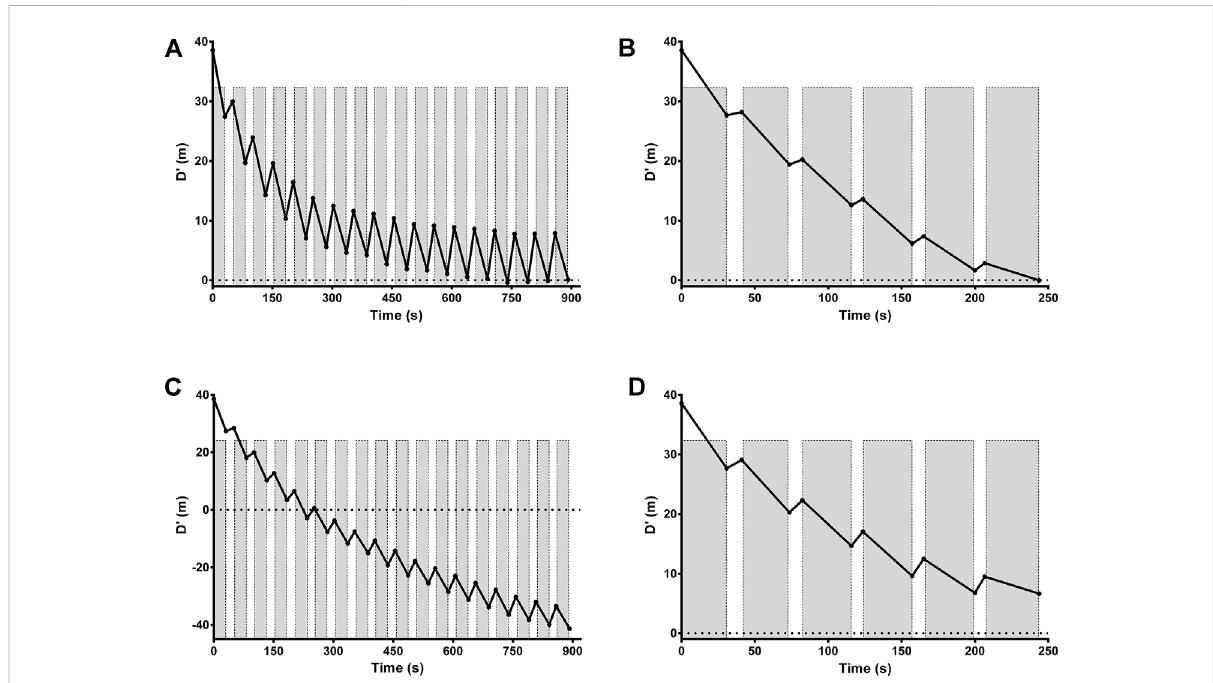
Modeled D ’ BAL depletion and reconstitution for a representative swimmer in training sessions with a work/relief ratio of 2:1 (A) and 4:1 (B) . An example for thesame representativeswimmer ofindividualD ’ BAL model when τ D ′ wereinverted intraining sessionswith awork/reliefratio of 2:1 (C) andT4:1 (D) .GraybarsindicateworkintervalswithD ′ depletionwhilewhitespaceindicatesrecoveryintervalswithD ′ reconstitution.Blacklineshows D ′ during depletion and reconstitution cycles. Horizontal dotted line represents D ′ equals zero and, in theory, the moment when the swimmer reaches volitional